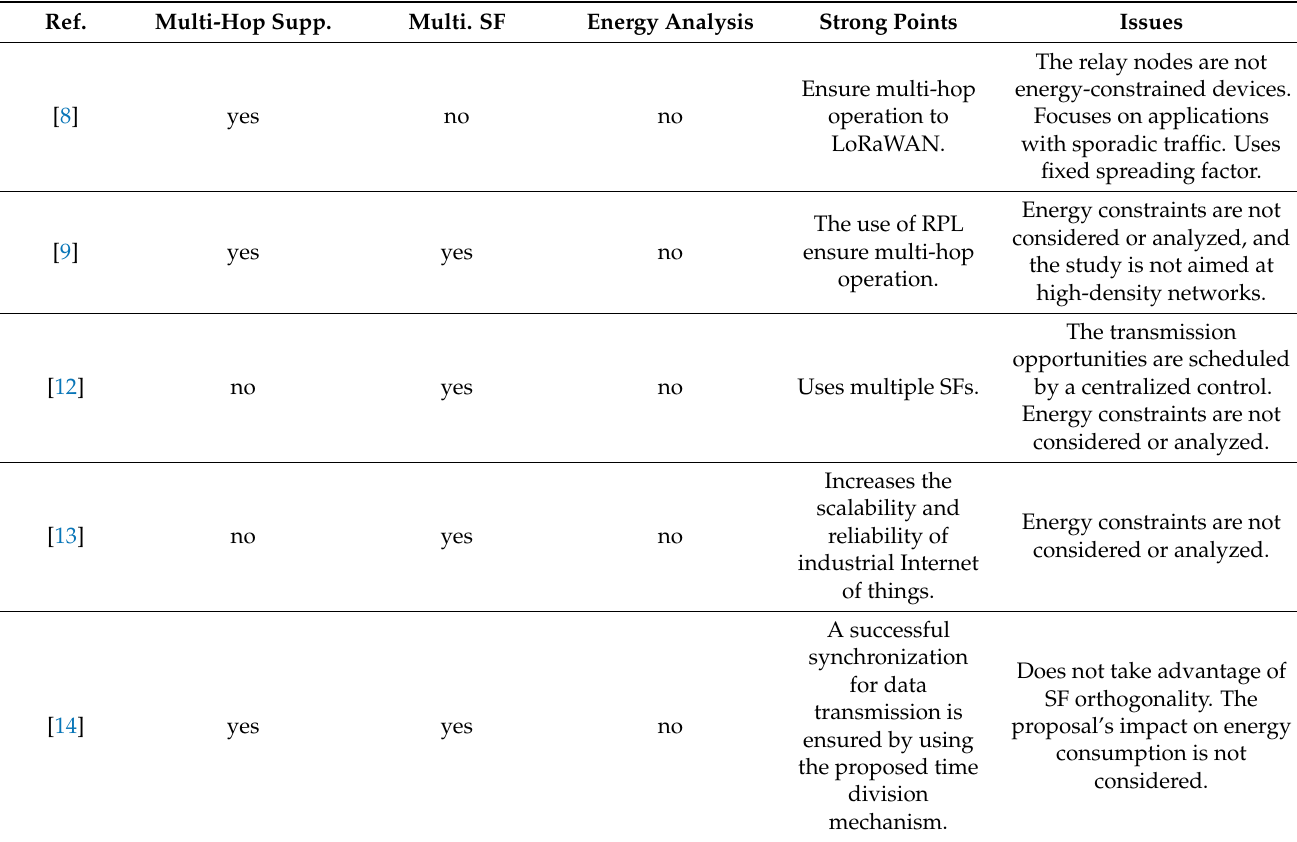
Table 1. Summary of previous